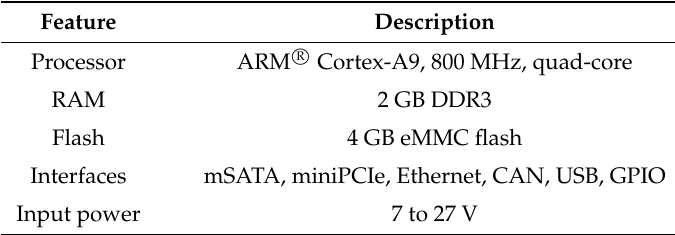
Figure 2. A single board computer was selected as the core computing hardware. Table 2. Highlights of single board computer